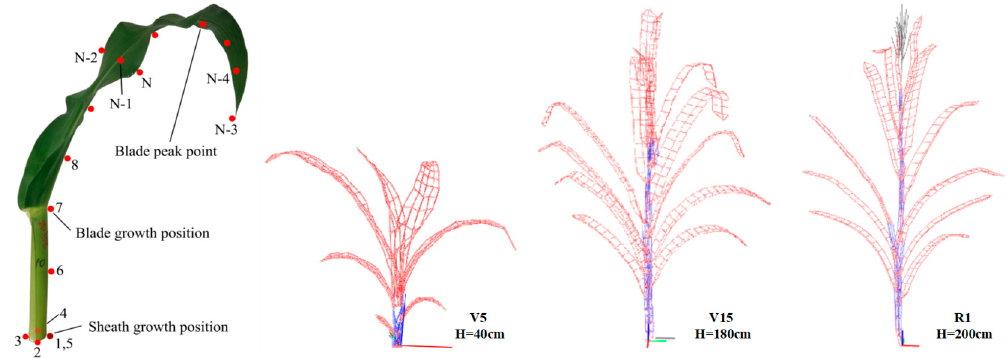
Figure 3. 3D digitizing principle of a phytomer and three 3D digitizing visualization result of maize plants at three growth stages.